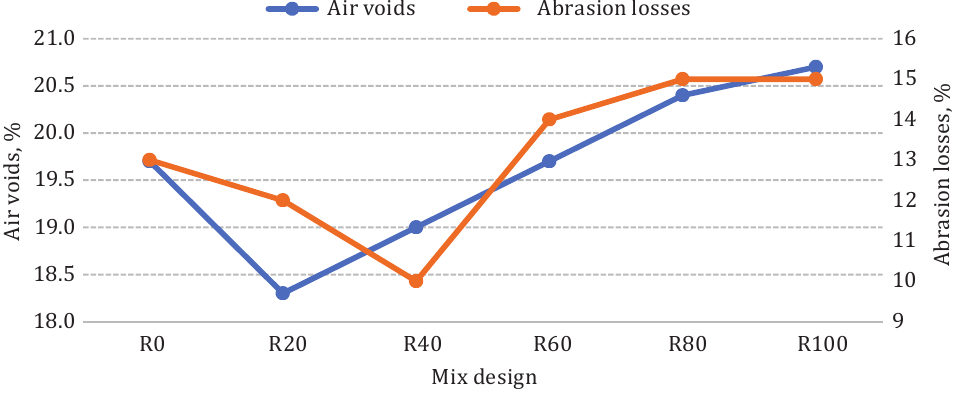
Figure 2. Design air voids and abrasion